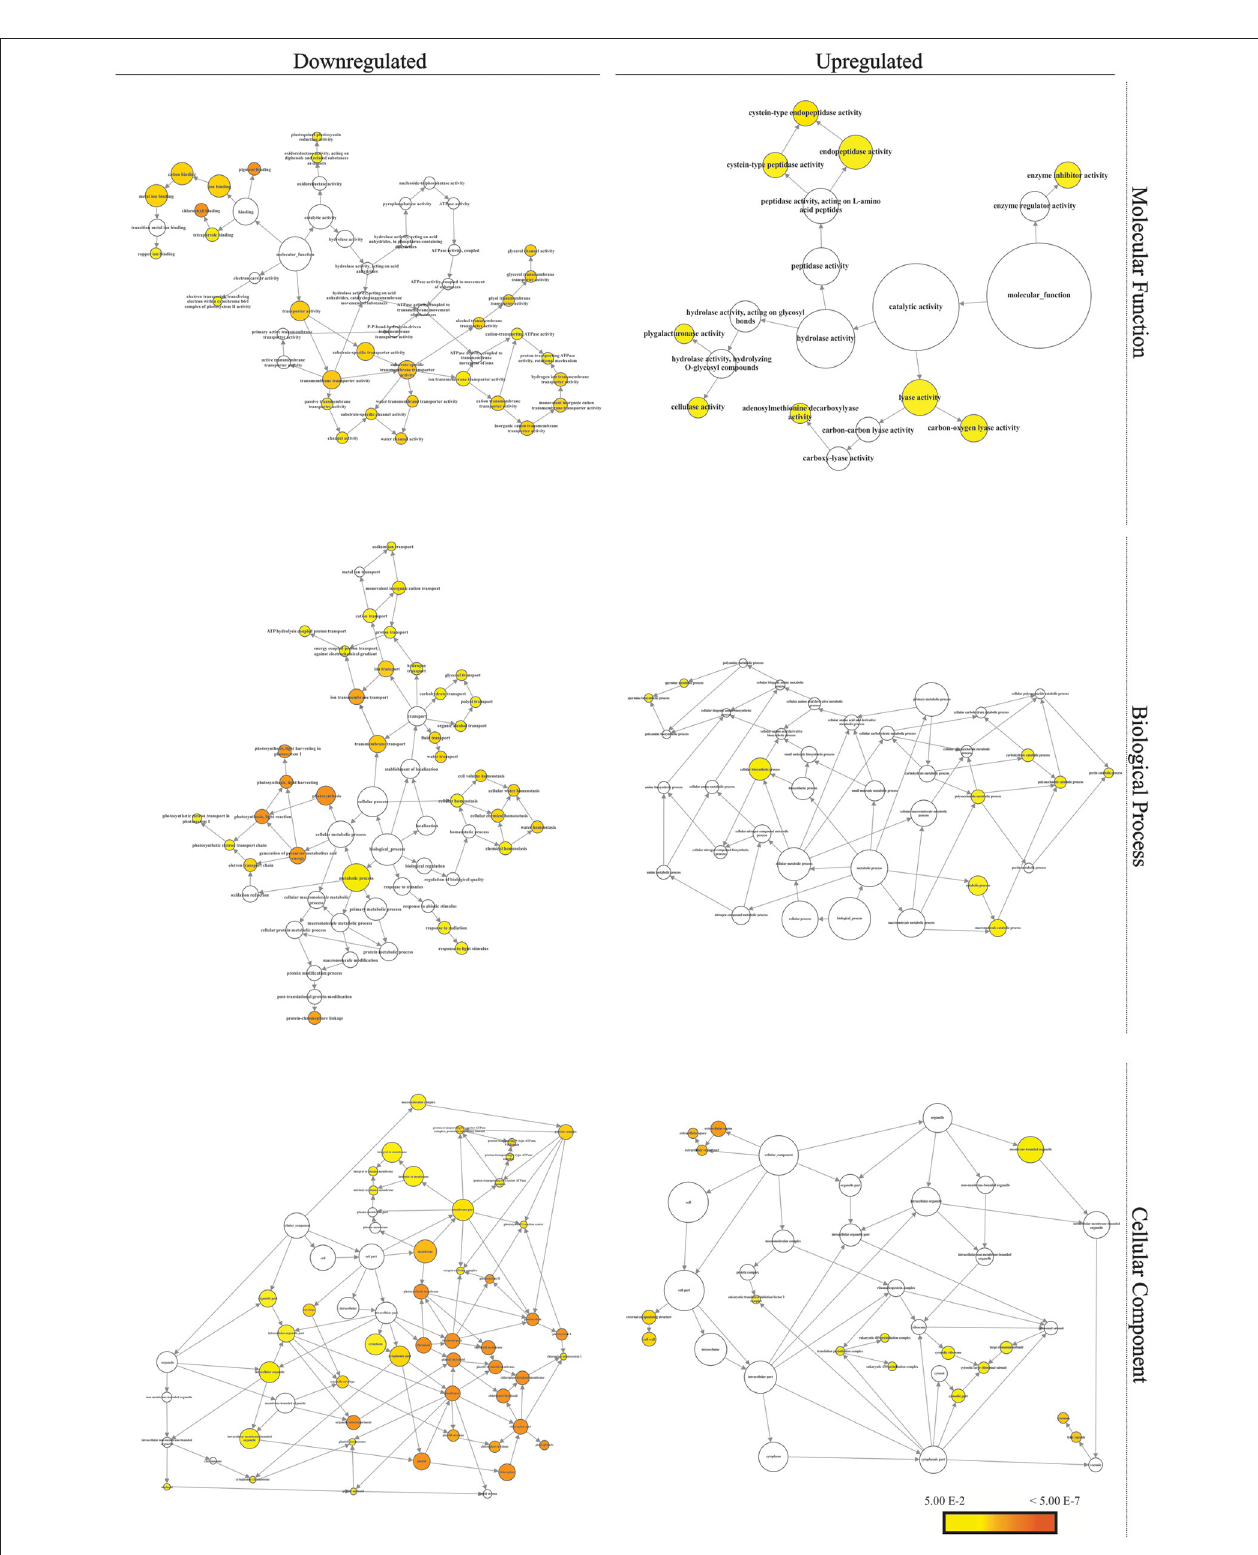
FIGURE 6 | Networks of differentially expressed genes. The networks were developed using GO categories in BiNGO for M. glaucescens explants before (control) and after (treated) shoot organogenesis induction. Bubble size and color indicate the frequency of the GO term and the P -value, respectively.